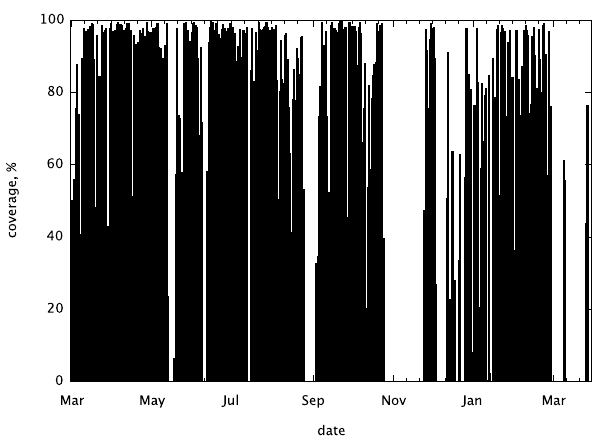
Fig. 1. The fraction of time inside a day covered by observation within the